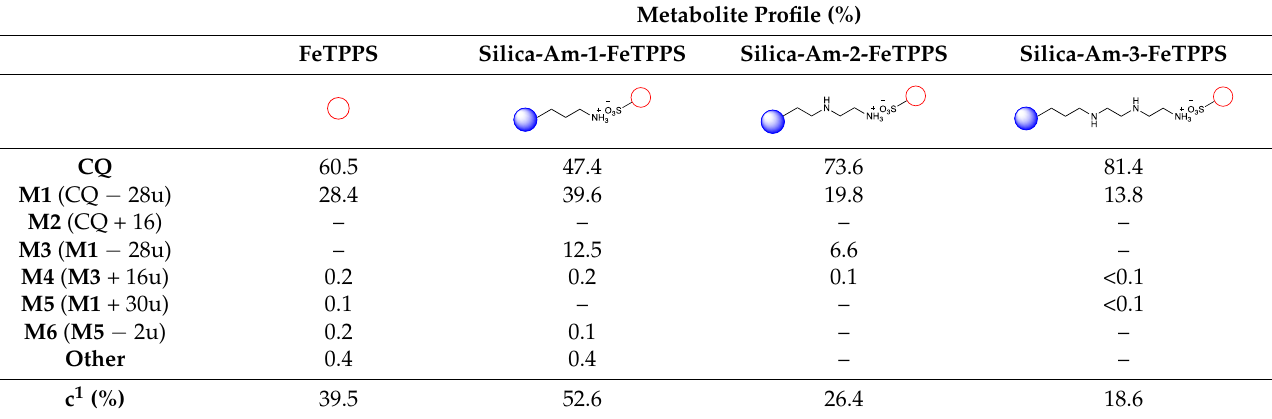
Table 2. Component analysis of dissolved FeTPPS and immobilzed FeTPPS metalloporphyin onto amino-functionalized silica particles (Silica-Am-1-FeTPPS, Silica-Am-2-FeTPPS and Silica-Am-3- FeTPPS) catalyzed biomimetic oxidation of chloroquine in batch mode. Each test was performed in triplicate, Stdr < 5%.